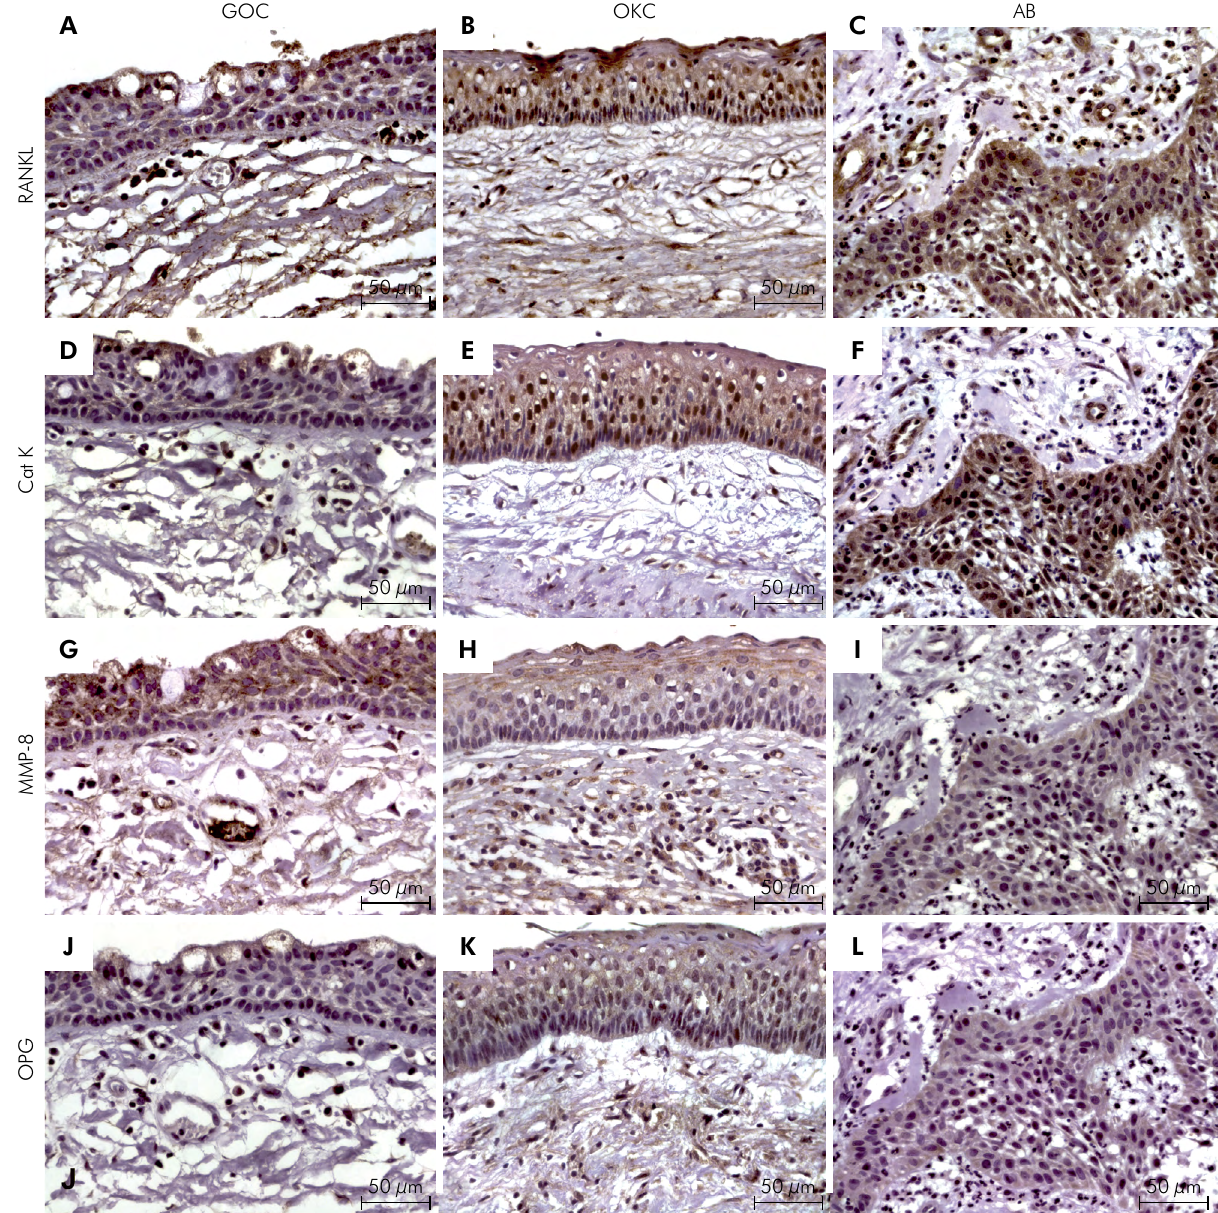
Figure 2. Immunoexpression of RANKL, CatK, MMP8 and OPG in glandular odontogenic cyst (GOC), odontogenic keratocyst (OKC), and ameloblastoma (AB). Note the high expression of RANKL (C) and CatK (F) in the parenchyma and stroma of AB. High expression levels are seen in the cystic epithelium and capsule of OKC (B and E) and lower expression levels in GOC (A and D). Expression of MMP8 is evident in the cytoplasm and nucleus of epithelial and mesenchymal cells of GOC (G, OKC (H) and AB (I). OPG is less evident in GOC (J), OKC (K) and AB (L).